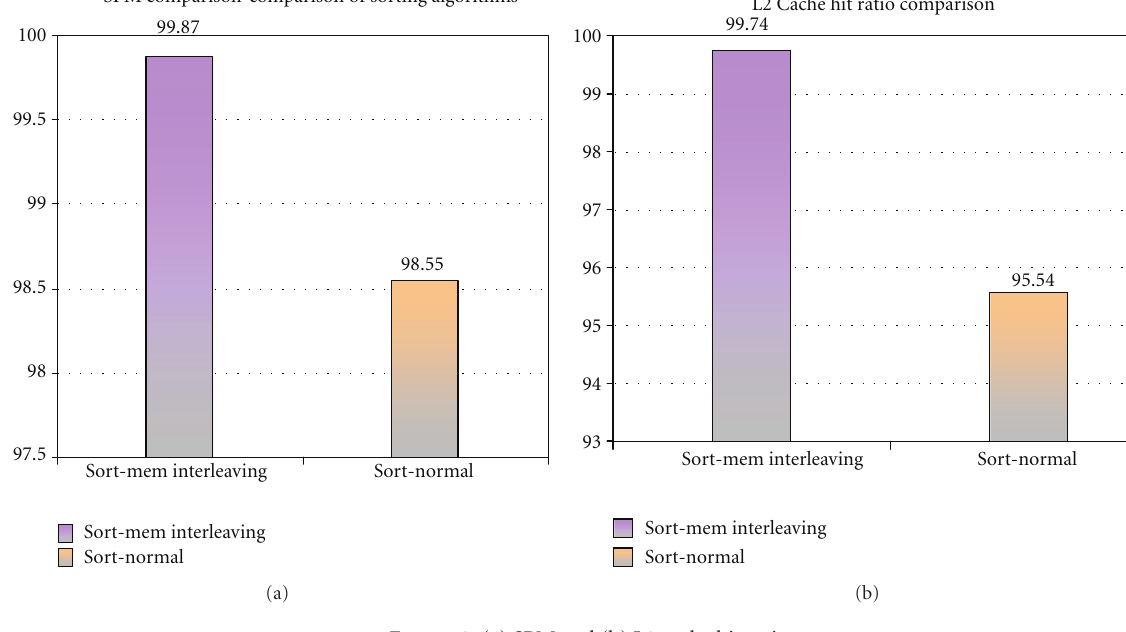
Figure 3: (a) SPM and (b) L2 cache hit ratio.